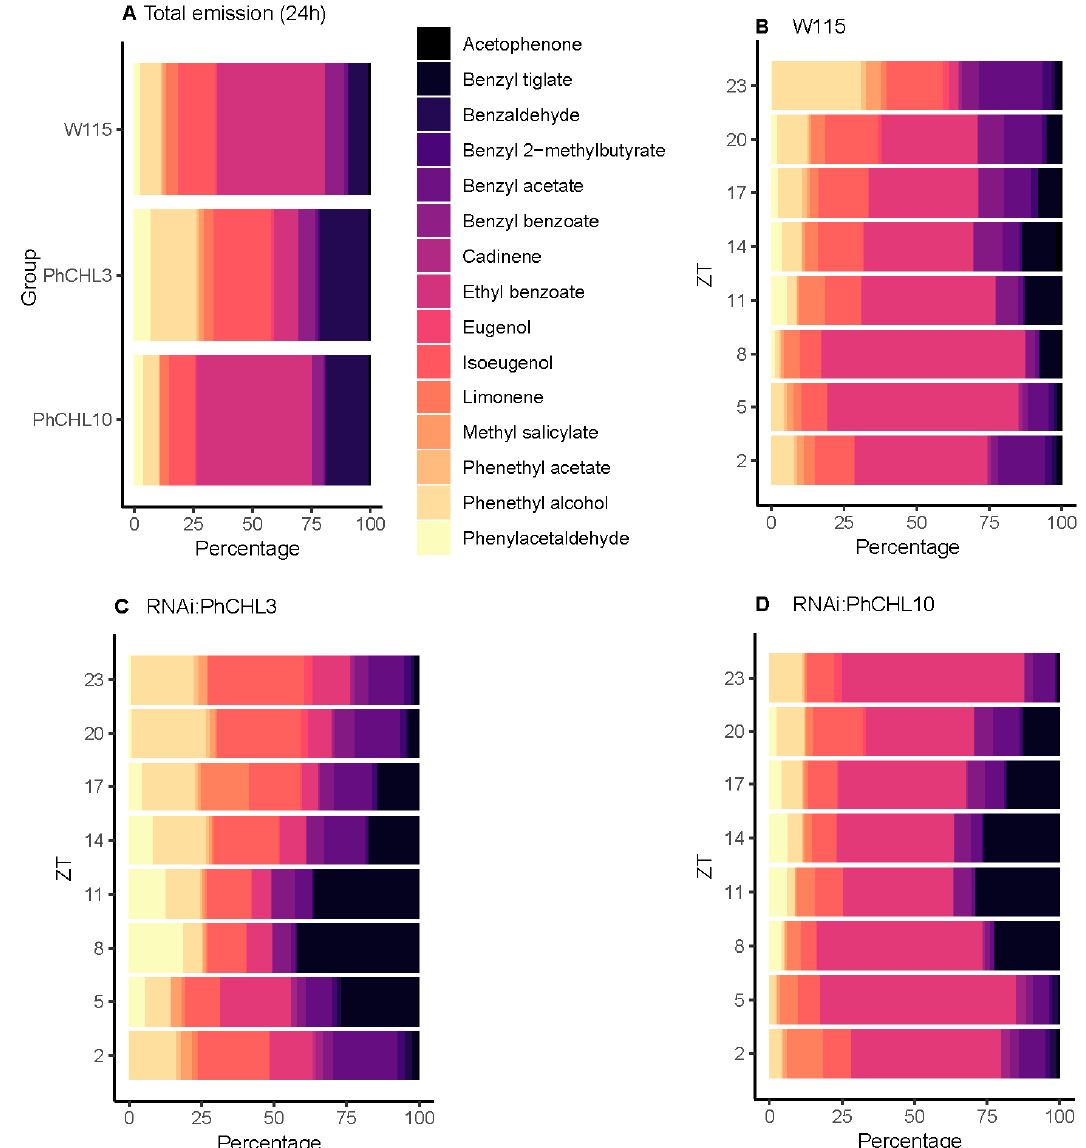
RNAi:PhCHL lines: benzaldehyde, phenylacetaldehyde, benzyl tiglate and benzyl 2-methylbutyrate (Figure 5A). The volatiles limonene, benzyl benzoate and acetophenone decreased their emission in RNAi:PhCHL3 and RNAi:PhCHL10 petunia flowers (Figure 5A) Finally, the quantities of some emitted volatiles varied among lines; the emission of benzyl acetate, cadinene, methyl salicylate, phenethyl acetate and phenethyl alcohol was higher in RNAi:PhCHL3 , whereas the quantities of these compounds decreased in the RNAi:PhCHL10 line (Figure 5A). Cells 2019 , 8 , x FOR PEER REVIEW